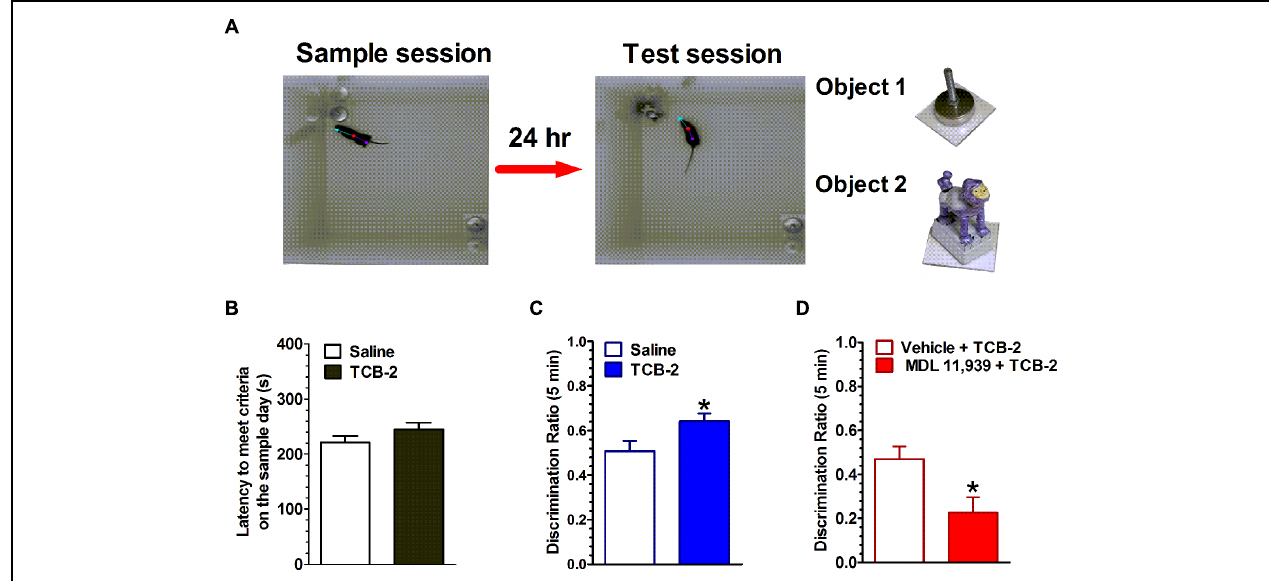
FIGURE 1 | Activation of 5-HT 2A Rs enhances the consolidation of object memory. (A) Experimental strategy. Left, during the sample session, mice were allowed to explore two identical novel objects each for at least 15 s, or either one for 18 s within a 10-min sample session. Middle, during the test session 24 h later, one of the objects (a cabinet leveling foot) was replaced with a novel object (a plastic toy monkey) and mice were individually reintroduced to the arena. Right, the objects used in this study. (B) There was no difference in the latency to achieve exploration criteria during the sample session between the saline- and